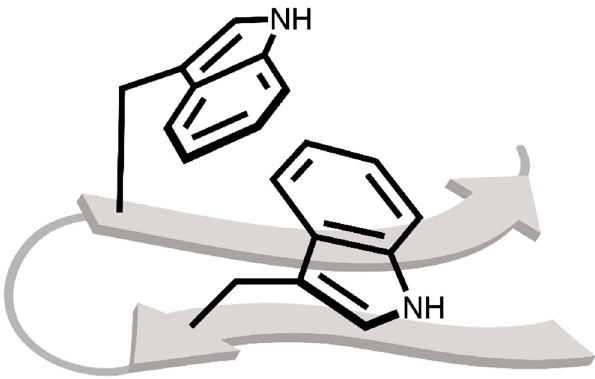
Figure 2. Schematic representation of a TrpZip peptide, only displaying the backbone as a cartoon graphic and the indole side chain bonds. The image focusses in on the indole rings that interdigitate in a zipper-like fashion.